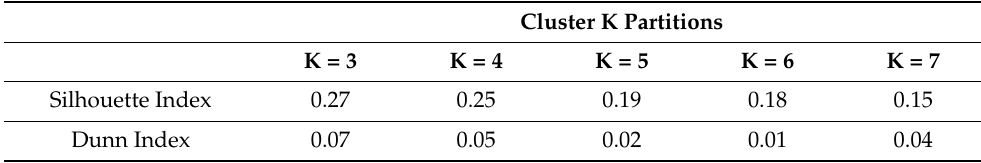
Table 1. Silhouette and Dunn index values 1 of internal cluster variance and consistency for three